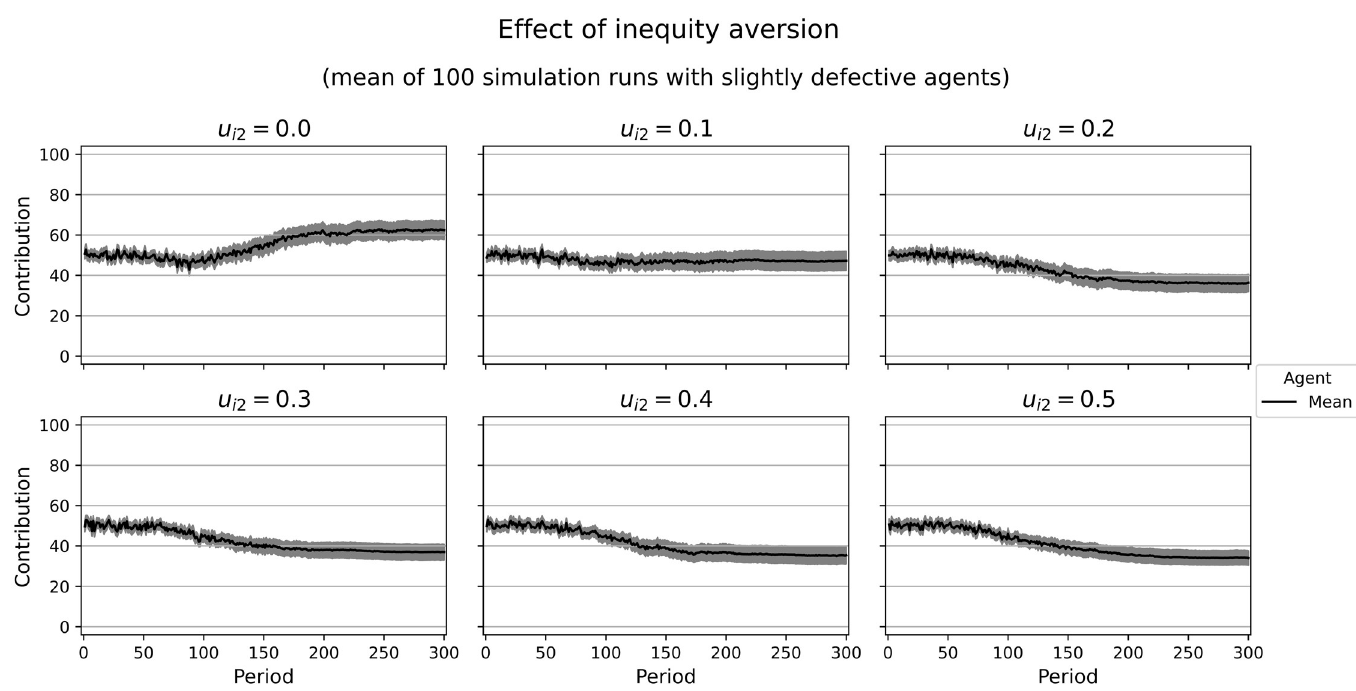
Fig 6. Contributions of rather selfish agents with different weights of inequity aversion. Selfishness: 0.70, competitiveness: 0, social welfare: 0, altruism: 0.30. Marginal utility of the own contribution: -0.03. In gray: confidence interval (95%) around the mean.